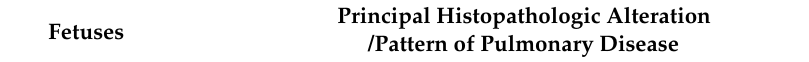
Table 4. Principal histopathological findings, patterns of pneumonia, and infectious agents observed in the lungs of bovine fetuses by immunohistochemistry and molecular